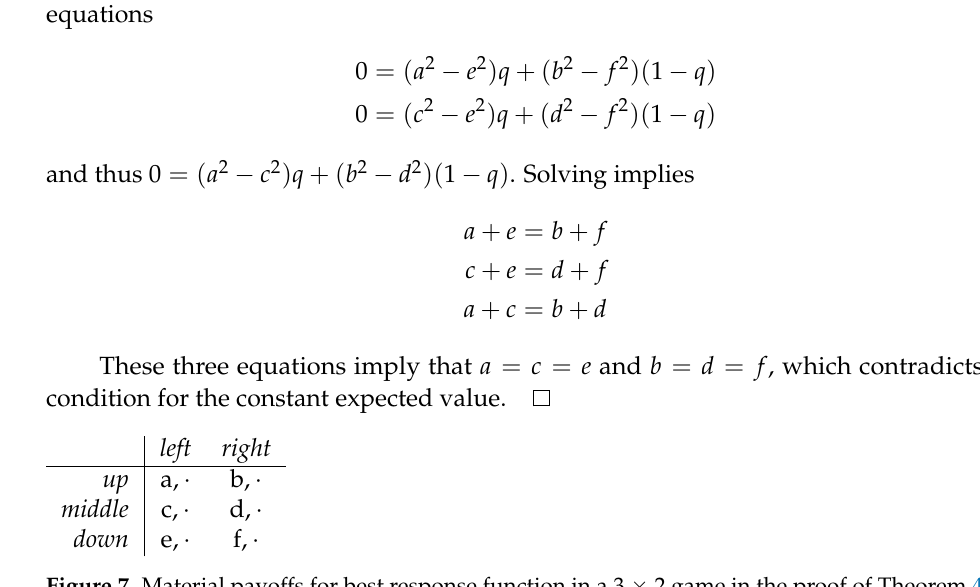
Figure 7. Material payoffs for best response function in a 3 × 2 game in the proof of Theorem 4.